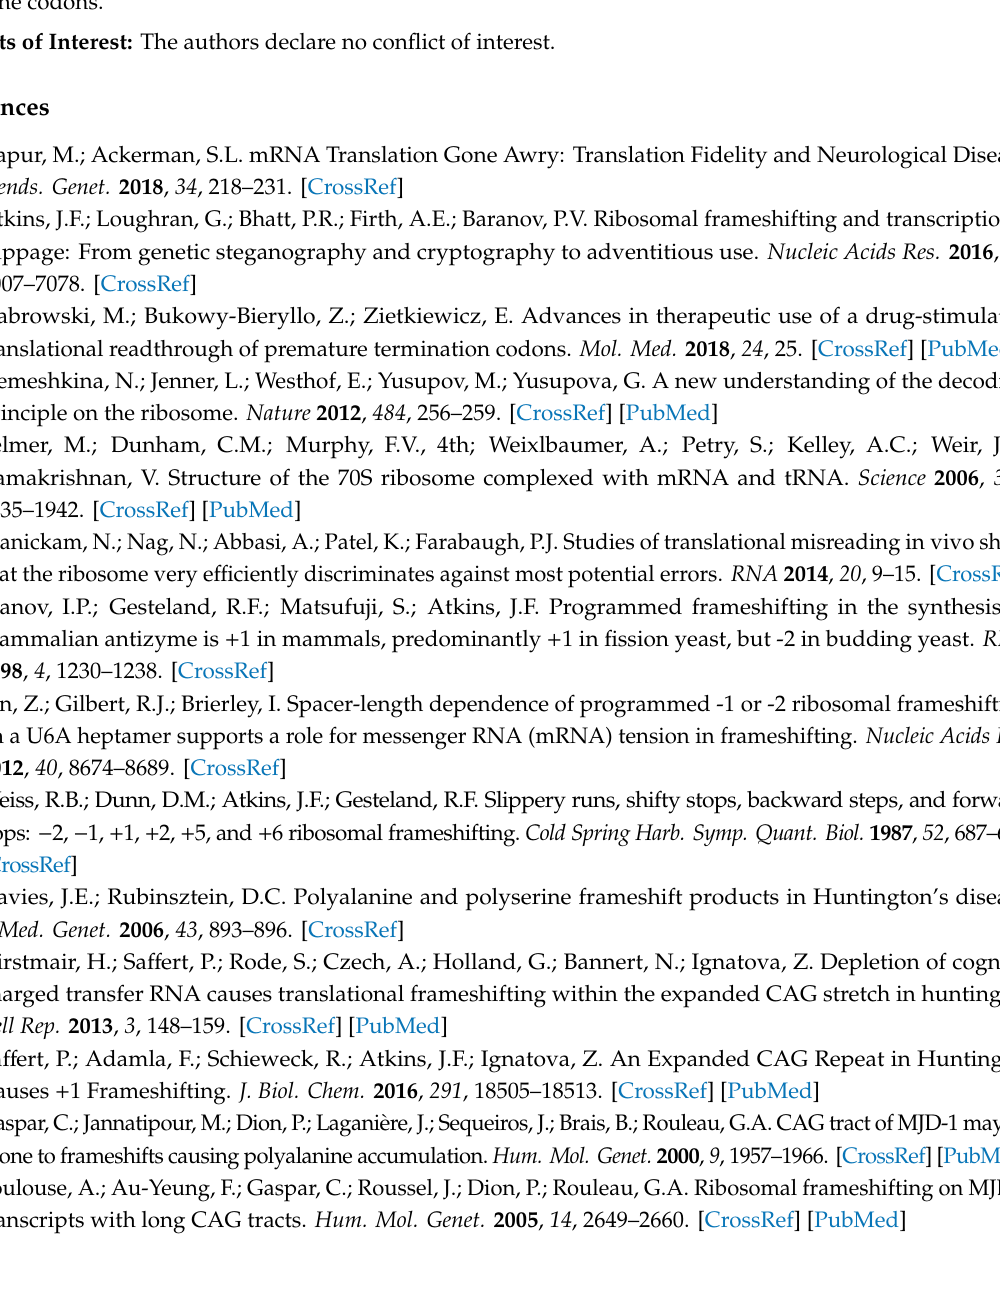
Figure S1: title, Table S1: title, Video S1: title. Calculations for conversion between MdMD biased and unbiased simulation time: Sprint avg (N avg ) = T unbiased , where Sprint is 2ps or 10 ps and N avg is average number of attempts to get to next archived sprint run (typically 10–15 times on average), which results in e ff ective time sampling of 25 ps per archived frame of MdMD. Example: U36: MD sprint-size × N rejection-rate = (2ps × 10–15) = ~25 ps per